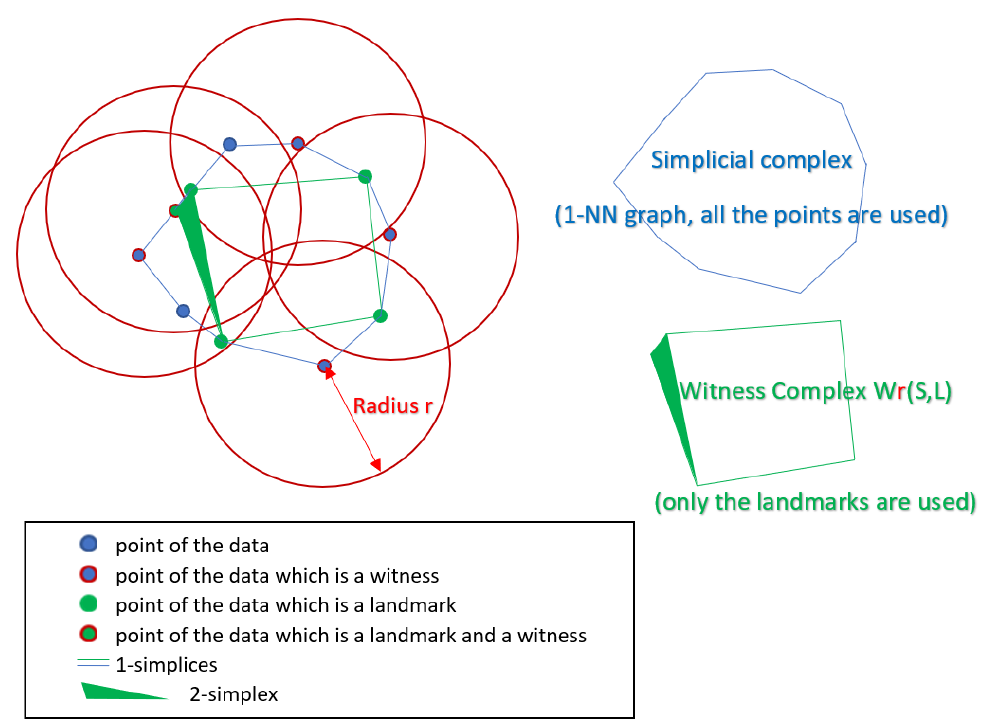
Figure 3. Example of the construction of a witness complex W r ( S , L ) for a dataset S ⊂ R 2 of 11 points using a subset L ⊂ S of 5 landmarks points and for a given radius r ∈ R .